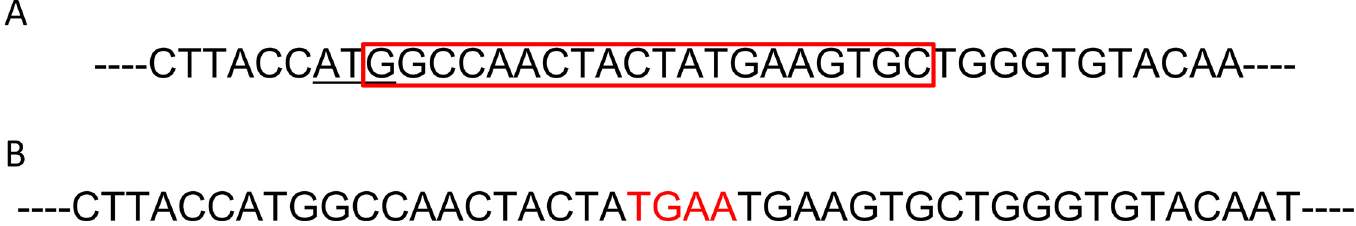
Fig 1. Design of the target sequence for CRISPR/cas9. (A) Target sequence of CRISPR/Cas9 construct. The bar indicates the start codon of Dnajb8. (B) The design of ssDNA. Stop codon (TGAA) is inserted.